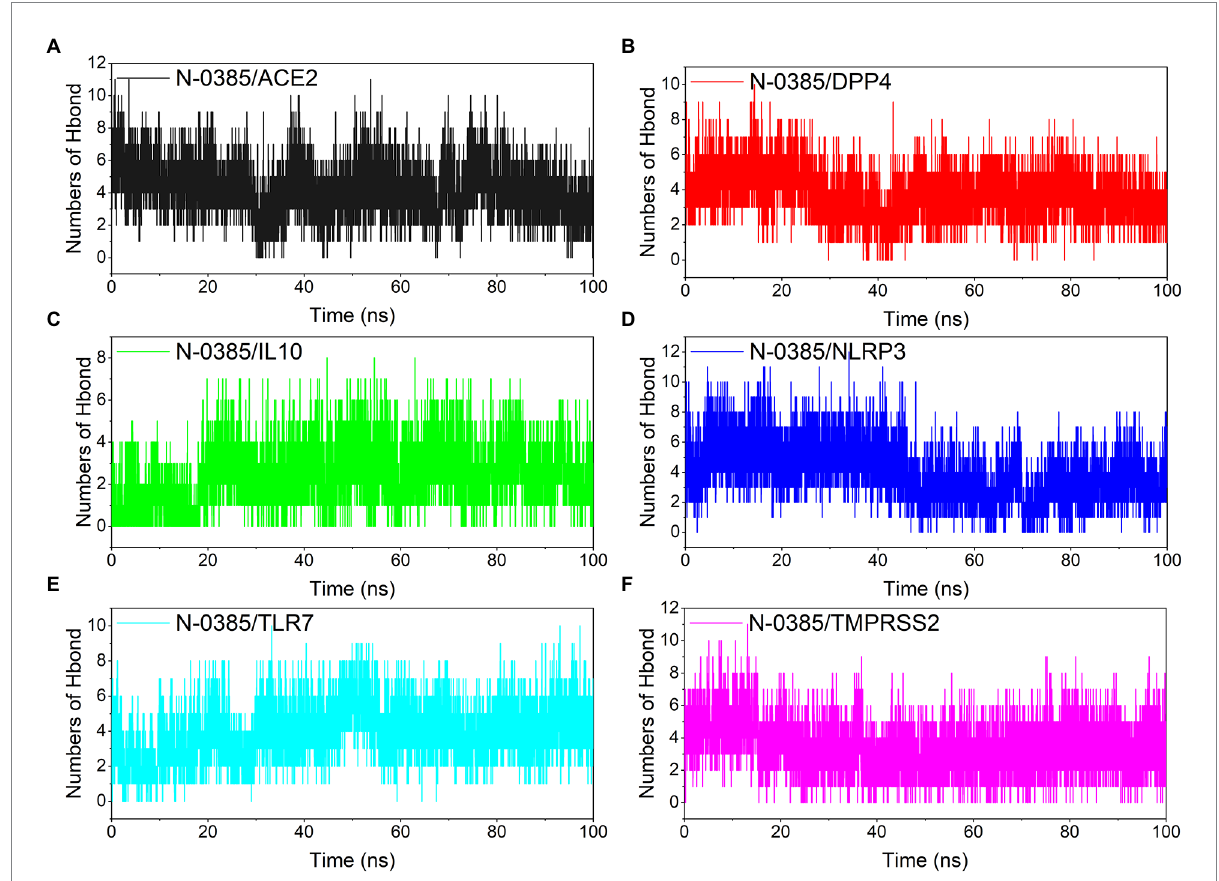
FIGURE 6 Changes in the number of hydrogen bonds among small molecule ligands and protein receptors in complex system simulations. (A) N-0385/ ACE2, (B) N-0385/DPP4, (C) N-0385/IL-10, (D) N-0385/NLRP3, (E) N-0385/TLR7, (F)